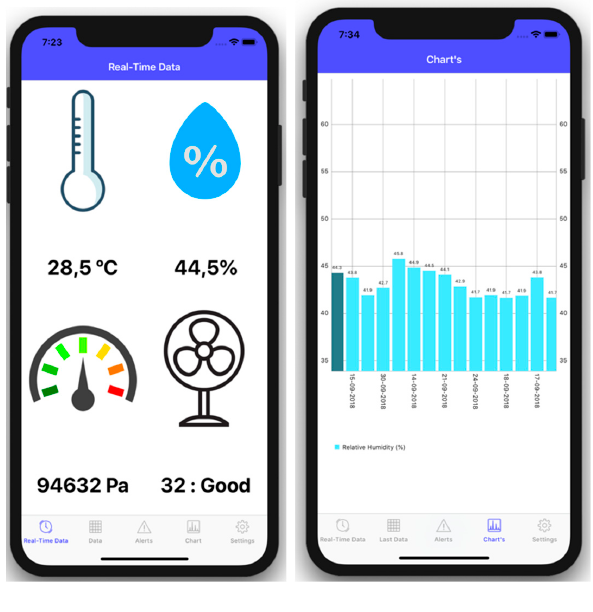
Figure 3. iAQ+Mobile